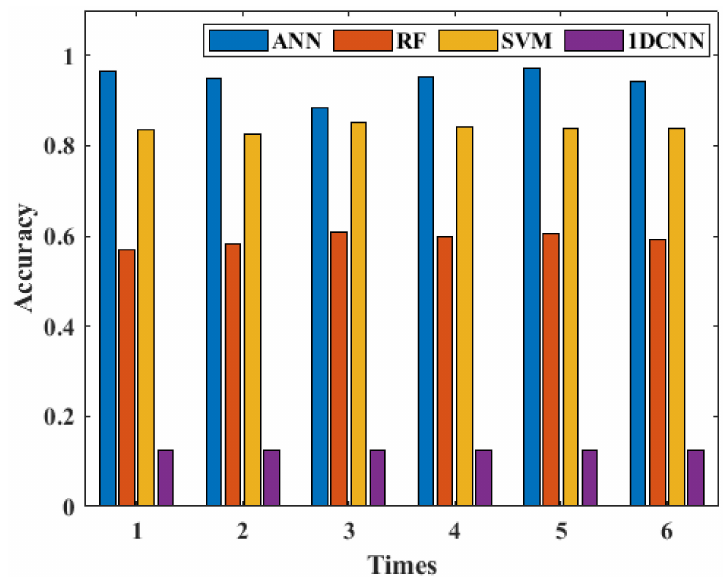
Figure 11. Comparison of ANN, SVM, RF and 1D CNN